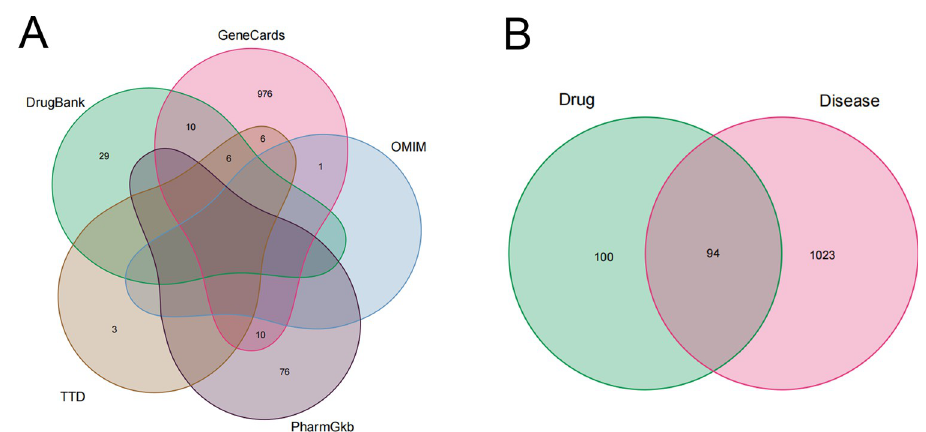
Fig 2. Identification of the drug-target interactions. (A) Identification of endometriosis-related genes by combining all the results from 5 databases. (B) Identification of the drug-target disease-related genes by taking an intersection of drug target genes and endometriosis-related genes.